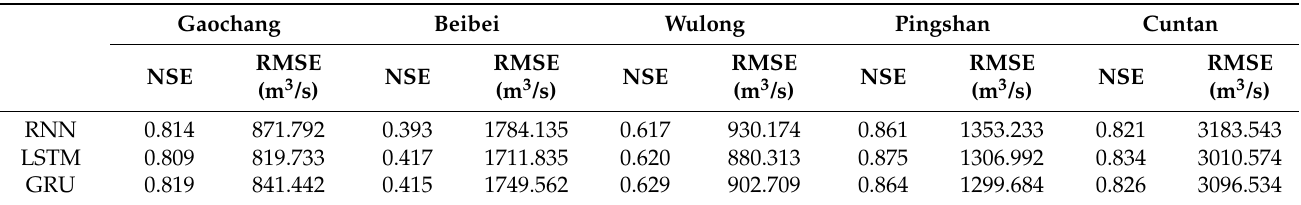
Table 6. The performance of RNN, LSTM, and GRU models at ten-day runoff prediction with optimal time lag and lead time.